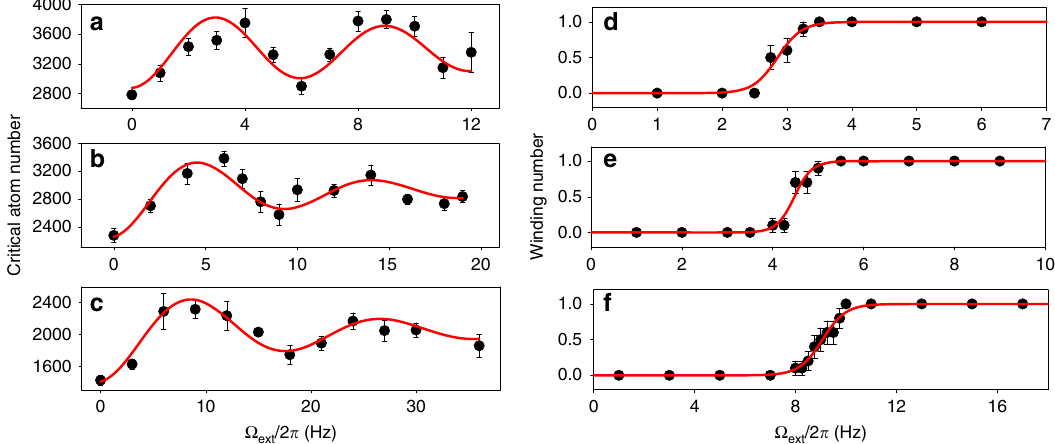
Fig. 3 Measurement of the periodic modulation of the critical atom number. The error bars in the plots represent the standard error and the numbers inside the brackets represent one standard deviation uncertainty. The uncertainty in the radius of the atomtronic SQUID consists of the systematic uncertainty in the estimation of the radius, which is 3% of the radius and the statistical uncertainty. The radius for a and d is 4.82 (0.14) sys (0.01) stat µ m, for b and e is 3.85 (0.11) sys (0.02) stat µ m, for c and f is 2.891 (0.084) sys (0.022) stat µ m. The modulation periods for a – c were measured with a damped sine function fi tting. The transition point from the 0 to 1 winding number for d – f was determined with the fi tting function 1 = ð 1 þ e (cid:2) k ð Ω ext (cid:2) Ω 0 2 Þ Þ . Modulation periods (Hz) were found to be 5.99 (0.22), 9.52 (0.48), and 17.99 (0.64) for a – c , respectively. Ω 0 /2 π (Hz) were measured to be 5.70 (0.10), 8.96 (0.12), and 18.11 (0.35) for d – f ,